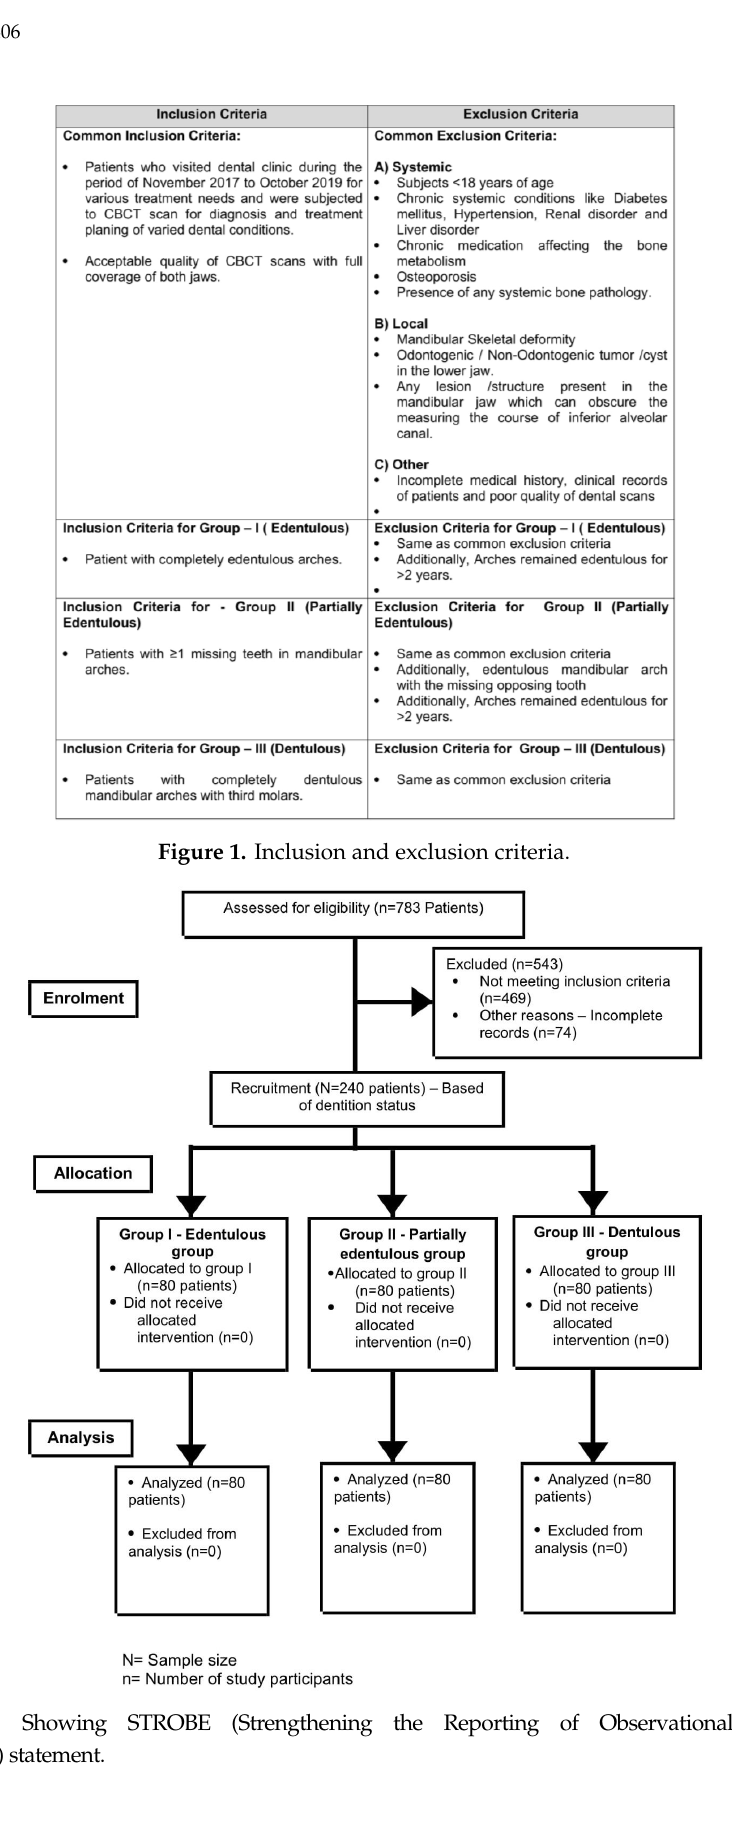
Figure 2. Showing STROBE (Strengthening the Reporting of Observational Studies in Epidemiology )